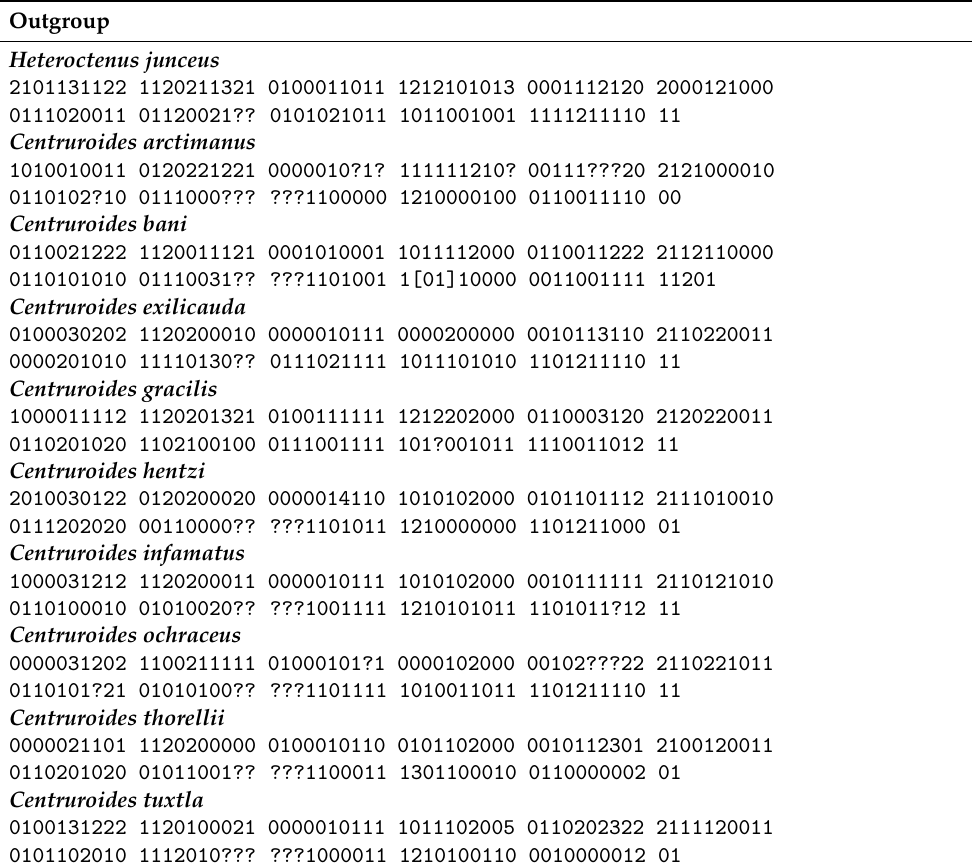
Table 1. Distribution of 112 morphological characters scored for phylogenetic analysis of the arboreal Neotropical ‘ thorellii ’ clade of Centruroides Marx, 1890 bark scorpions (Buthidae C.L. Koch 1837) and outgroup species of Centruroides and Heteroctenus junceus (Herbst, 1800). Character states are scored from 0 to 5, as unknown (?), or as polymorphic